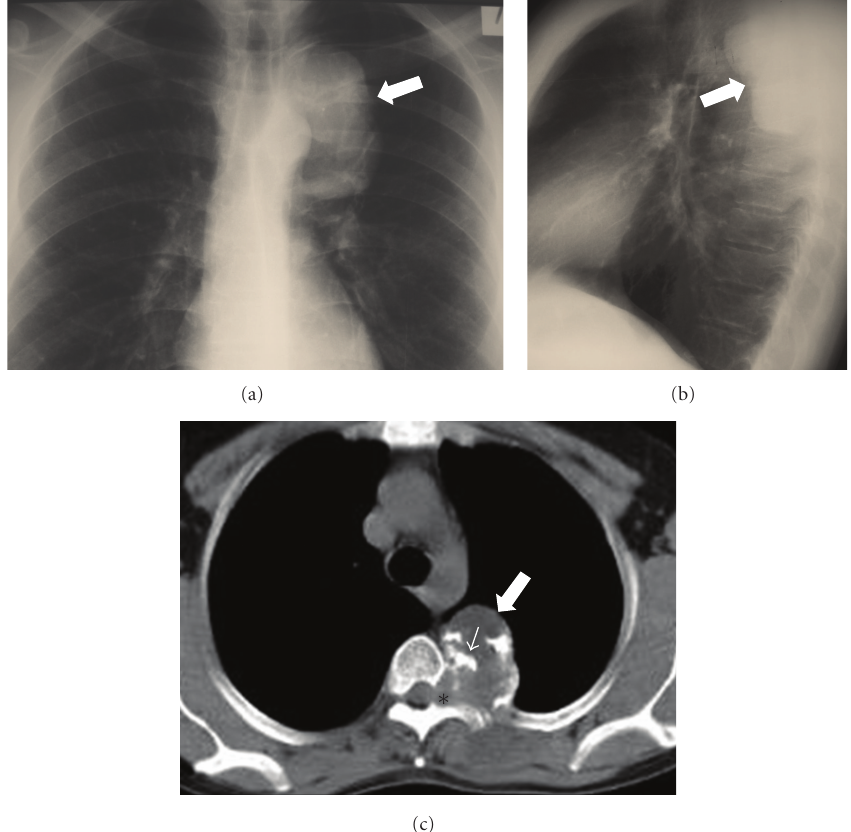
Figure 1: A 32-year-old man with chondrosarcoma. The posteroanterior (a) and lateral (b) chest radiographs, show a well-defined radiopaque lesion in the left posterior paraspinal location (arrows). (c) The axial MDCT image demonstrates a soft-tissue mass (arrow) with amorphous “rings and arcs” calcified matrix (thin arrow) and adjacent neural foramina widening (asterisk).